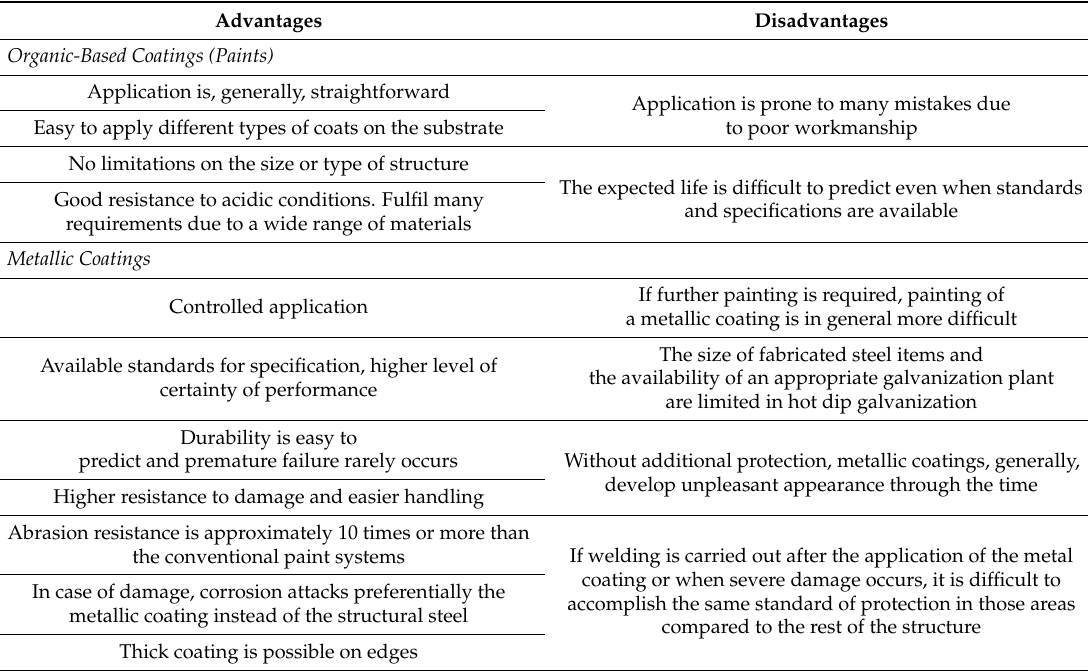
Table 10. Comparison of application methods for organic-based and metallic coatings (adapted from